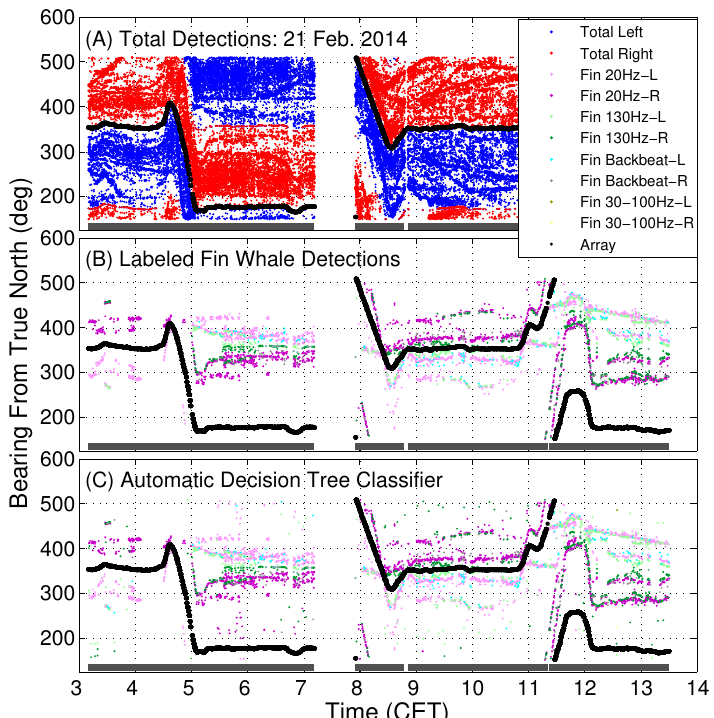
Figure 7. Fin whale vocalization classification results for the NorEx14 on 21 February 2014 (Alesund) using a decision tree classifier. Plot ( A ) displays the bearing-time trajectories of all acoustic signal detections between the 10 and 200 Hz frequency range. Blue and red dots correspond to left and right side bearings respectively for detections about the receiver array, before the line array’s left-right bearing ambiguity resolution. The black dots represent the array heading. Plot ( B ) displays the bearing-time trajectories of fin whale vocalization detections that were manually labeled, whereas plot ( C ) displays the fin whale vocalization detections that were identified by the decision tree